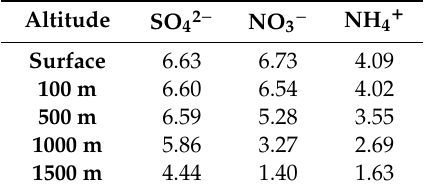
Figure 7. Vertical cross-section of SO 42 − concentration difference between BASE and R_FSO2 experiments. Table 1. The distribution of SO 42 − , NO 3 − , and NH 4 + concentrations ( µ g m − 3 ) according to altitude.